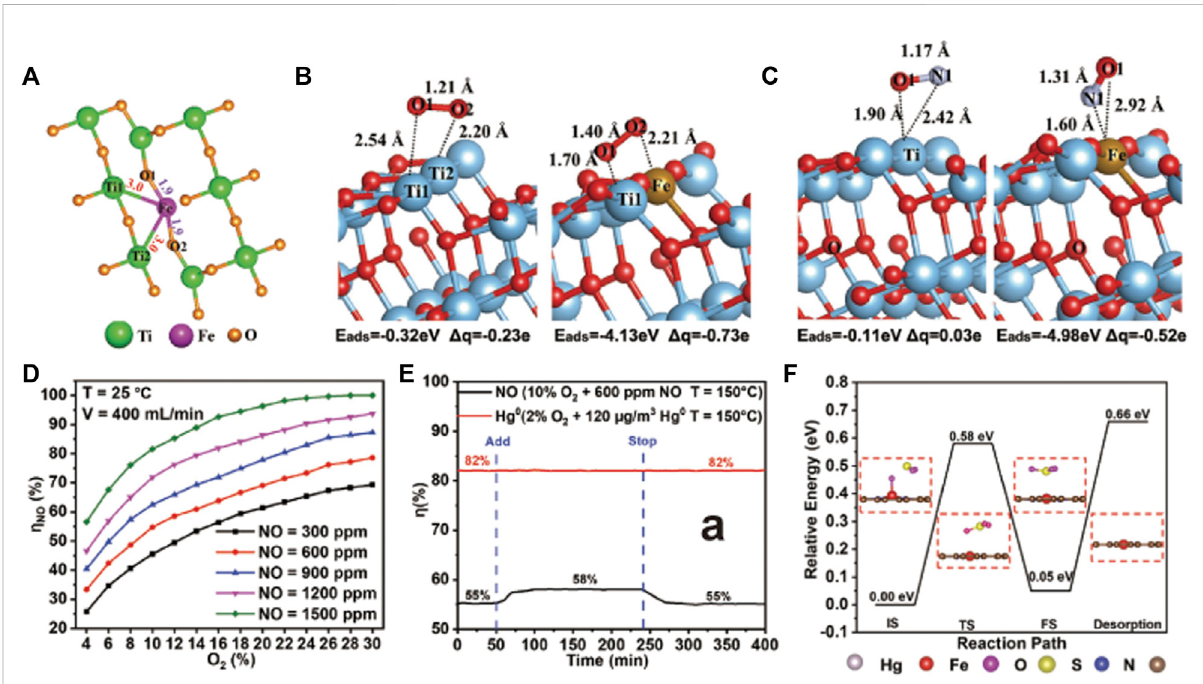
FIGURE 6 (A) Coordination structure ofFesingle-atoms;adsorption modelsof (B) O 2 and (C) NO onTiO 2 beforeand after theanchorofsingle atomicFe. Reprinted from Hu et al., 2020. Copyright 2020, with permission from Wiley-VCH GmbH. (D) NO oxidation rates on Fe 1 -N 4 -C for varied concentrationsof NOat25 ° C; (E) NO oxidation rateson Fe 1 -N 4 -Cwith 500 ppm SO 2 introduced; (F) Oxidationpath between SO 2 andtheadsorbed O atom on Fe site of Fe 1 -N 4 -C. Reprinted from Yang et al., 2020b. Copyright 2022, with permission from Wiley-VCH